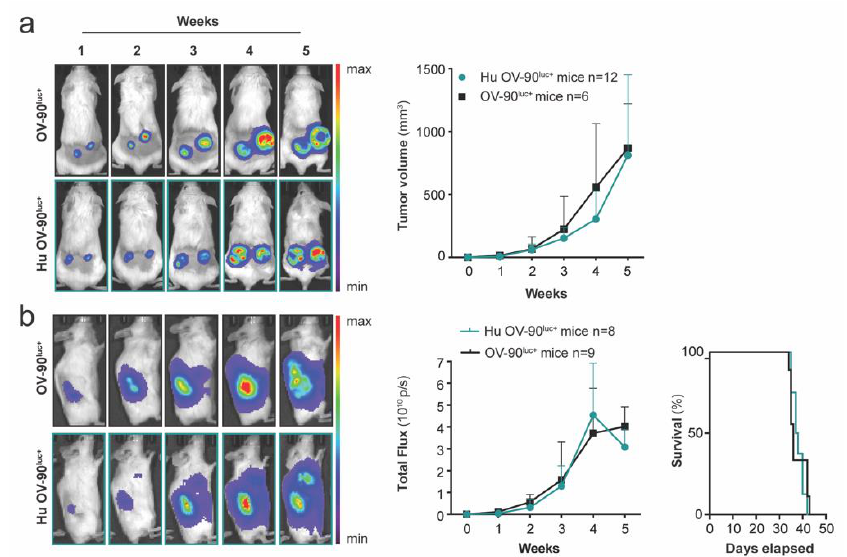
Figure 4. Humanized mice support the engraftment of subcutaneous and orthotopic epithelial ovar- ian cancer cells ( a ) Humanized (hu) and immunodeficient mice were engrafted subcutaneously with 5 × 10 6 OV-90 luc+ cells ( n =12, hu OV-90 luc+ mice; n = 6, OV-90 luc+ mice). Tumor growth was moni- tored by in vivo bioluminescence imaging and caliper measurements ((height × width × length × Π )/6). ( b ) Orthotopic OV-90 luc+ xenografts ( n = 8, hu OV-90 luc+ mice; n = 9 OV-90 luc+ mice) were imaged once a maximum bioluminescence intensity for each mouse.